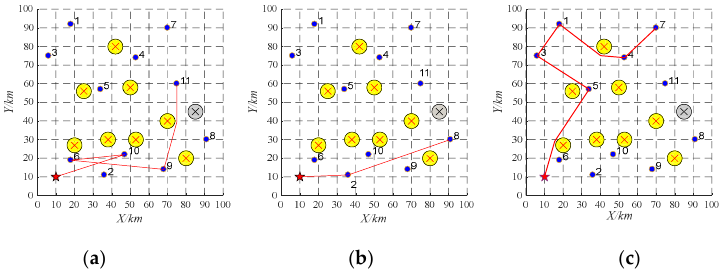
( c ) Figure 10. Task re-scheduling schemes with the emergency task based on replacement contract. ( a ) UAV-01; ( b ) UAV-02; ( c ) UAV-03.